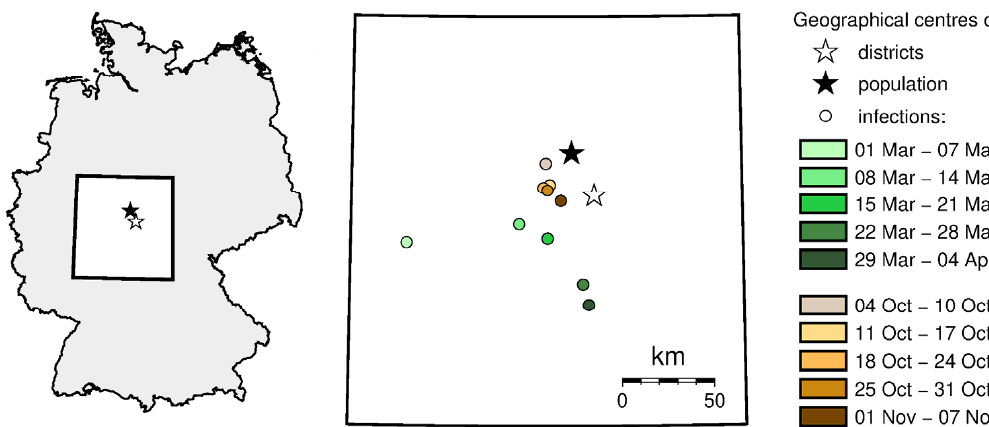
Figure 6. The geographic center of infections movement across the analyzed time (source: own work).